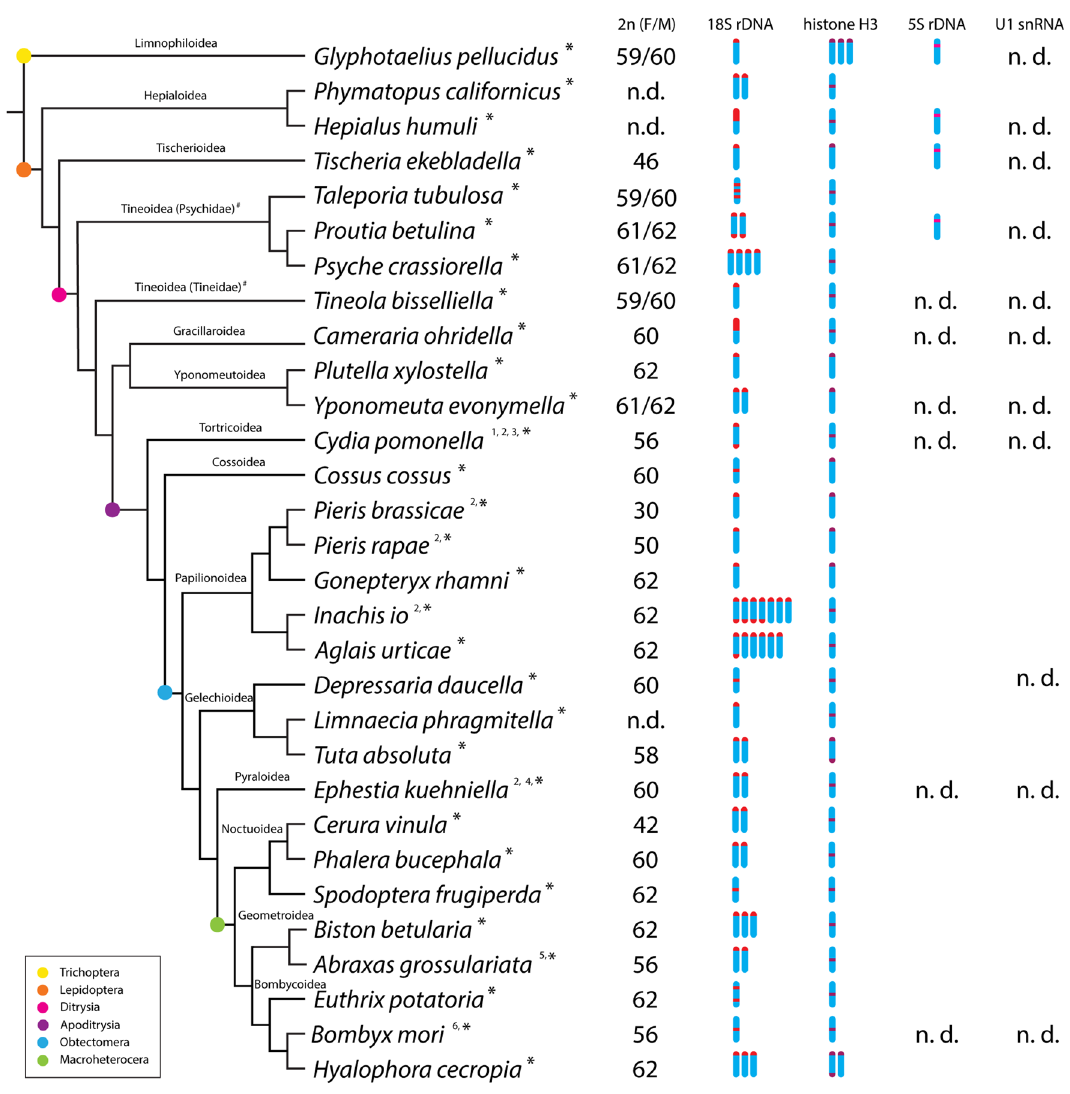
Figure 1. Overview of the number and position of 18S rDNA, histone H3, 5S rDNA, and U1 snRNA markers in haploid genomes of studied species. Phylogenetic relationships are based on Refs. 66–68 . # Tineoidea are considered paraphyletic. Data was obtained: *in this study; 1— 25 , 18S rDNA; 2— 29 , 18S rDNA; 3— 64 histone H3; 4— 69 , 18S rDNA; 5— 70 , 18S rDNA; 6— 31 , 18S rDNA. n.d.—not detected. F/M—female and male diploid chromosome numbers, if different. A complete list of all species analysed so far for the distribution of studied markers, including their chromosomal numbers and references, is given in Supplementary Table S2. The figure was created in Adobe Illustrator 2020, version 24.0 (www. adobe. Fig. S1a). Interestingly, various strong heterochromatin blocks in almost all chromosome bivalents were visible after staining with DAPI. Some of these heterochromatin patterns could potentially be used for chromosome identification. Hybridization of histone H3 probe revealed three terminal clusters of histone genes on three dif- ferent bivalents (Supplementary Fig. S1b). This is one of three cases in our study where we observed multiple histone clusters (Fig. 1). Two species of the superfamily Hepialoidea were examined, namely the ghost moth, Hepialus humuli , and the lupine ghost moth, Phymatopus californicus . Diploid chromosome numbers of these two species have not been described yet. Due to the lack of mitotic nuclei, we were not able to determine chromosomal numbers in this study. In H. humuli , the 18S rDNA probe highlighted approximately half of one pachytene bivalent (Supplemen- tary Fig. S1c). Hybridization signals colocalized with a DAPI-positive heterochromatin block. In P. californicus, two chromosomal bivalents were detected, each bearing an rDNA cluster at the chromosome terminus (Sup- plementary Fig. S1e). The histone H3 probe revealed one bivalent with an interstitial cluster of histone genes in both H. humuli and P. californicus (Supplementary Fig. S1d, f). The oak leaf miner, Tischeria ekebladella, was examined as a representative of the Tischeroidea superfamily. Its diploid chromosomal number 2n = 46 (for both sexes) was determined previously 72 . Indeed, n = 23 was con- firmed in this study (Supplementary Fig. S2a). After DAPI staining, a strong heterochromatin block with terminal